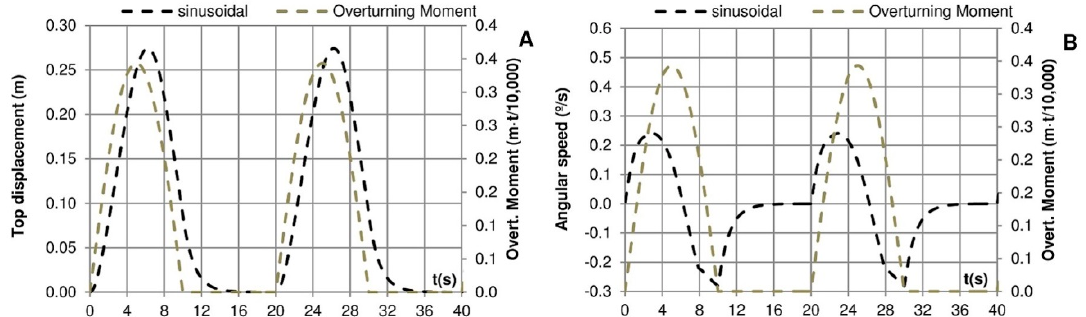
Figure 10. Sinusoidal force. ( A ) Movement on the top of the crown wall; ( B ) angular velocity, related to the overturning moment. E (MPa) = 10; 2 load cycles.